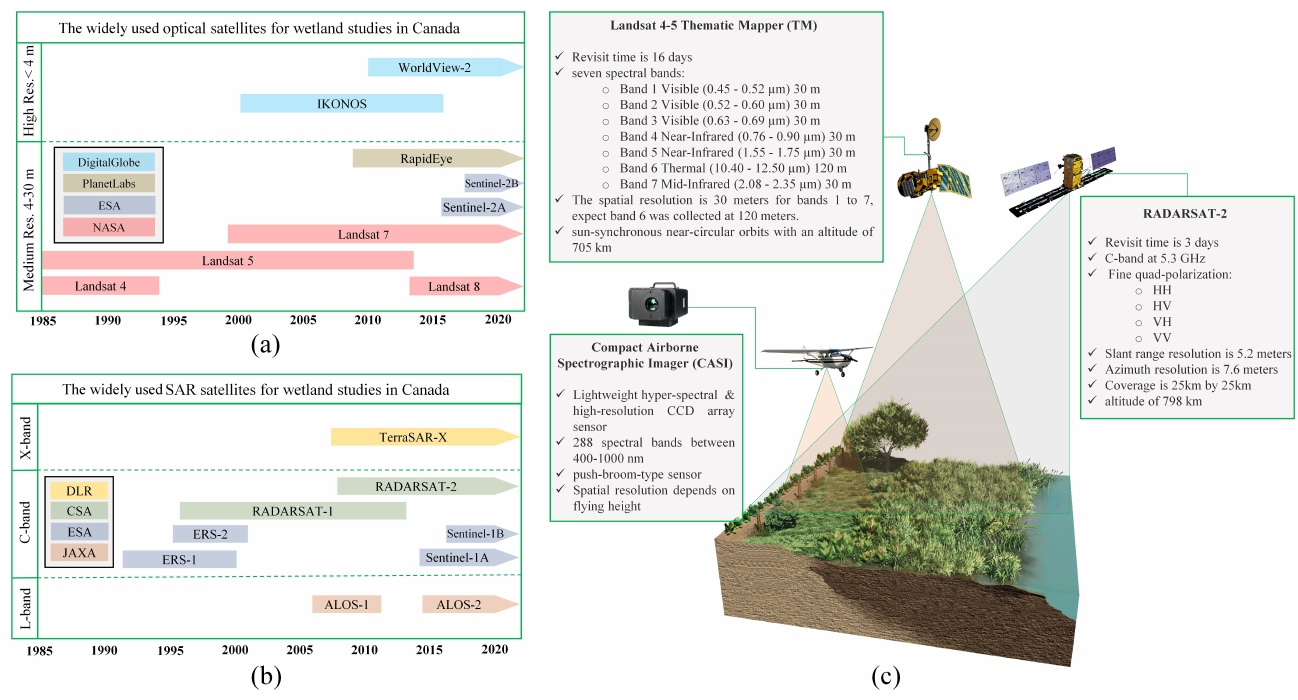
Figure 14. The frequently used ( a ) optical and ( b ) SAR satellites in wetland mapping in Canada and ( c ) the description of the most widely used RS